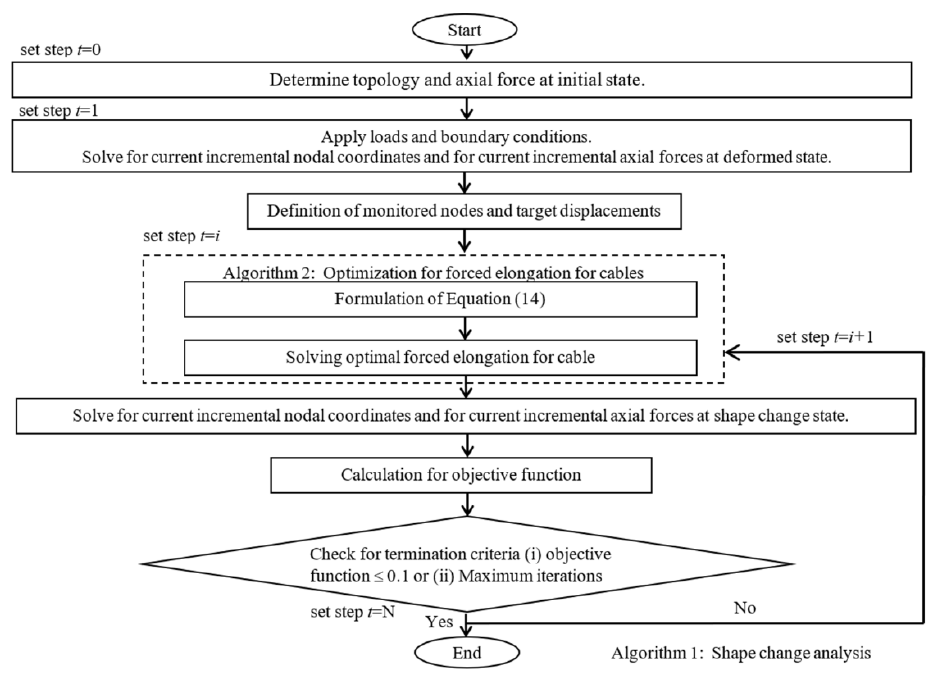
Figure 4. Algorithm for shape change analysis.